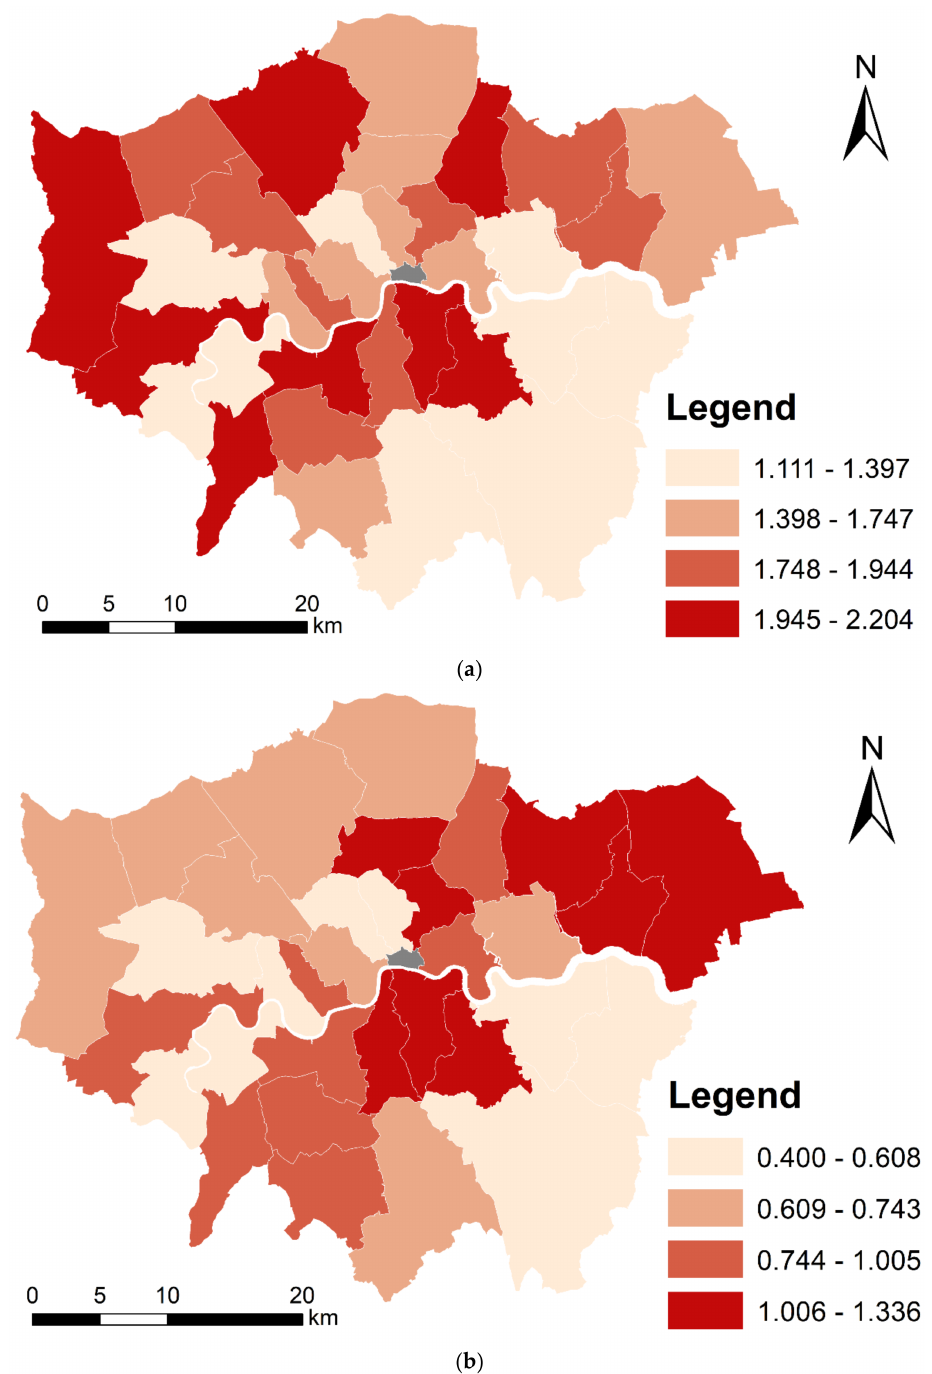
Figure 2. District-level crime rates (cases per 1000 persons) across London in April 2020. ( a ) Violence-against-the-person rate (values grouped into quantiles); ( b )Theft and handling rate (values grouped into